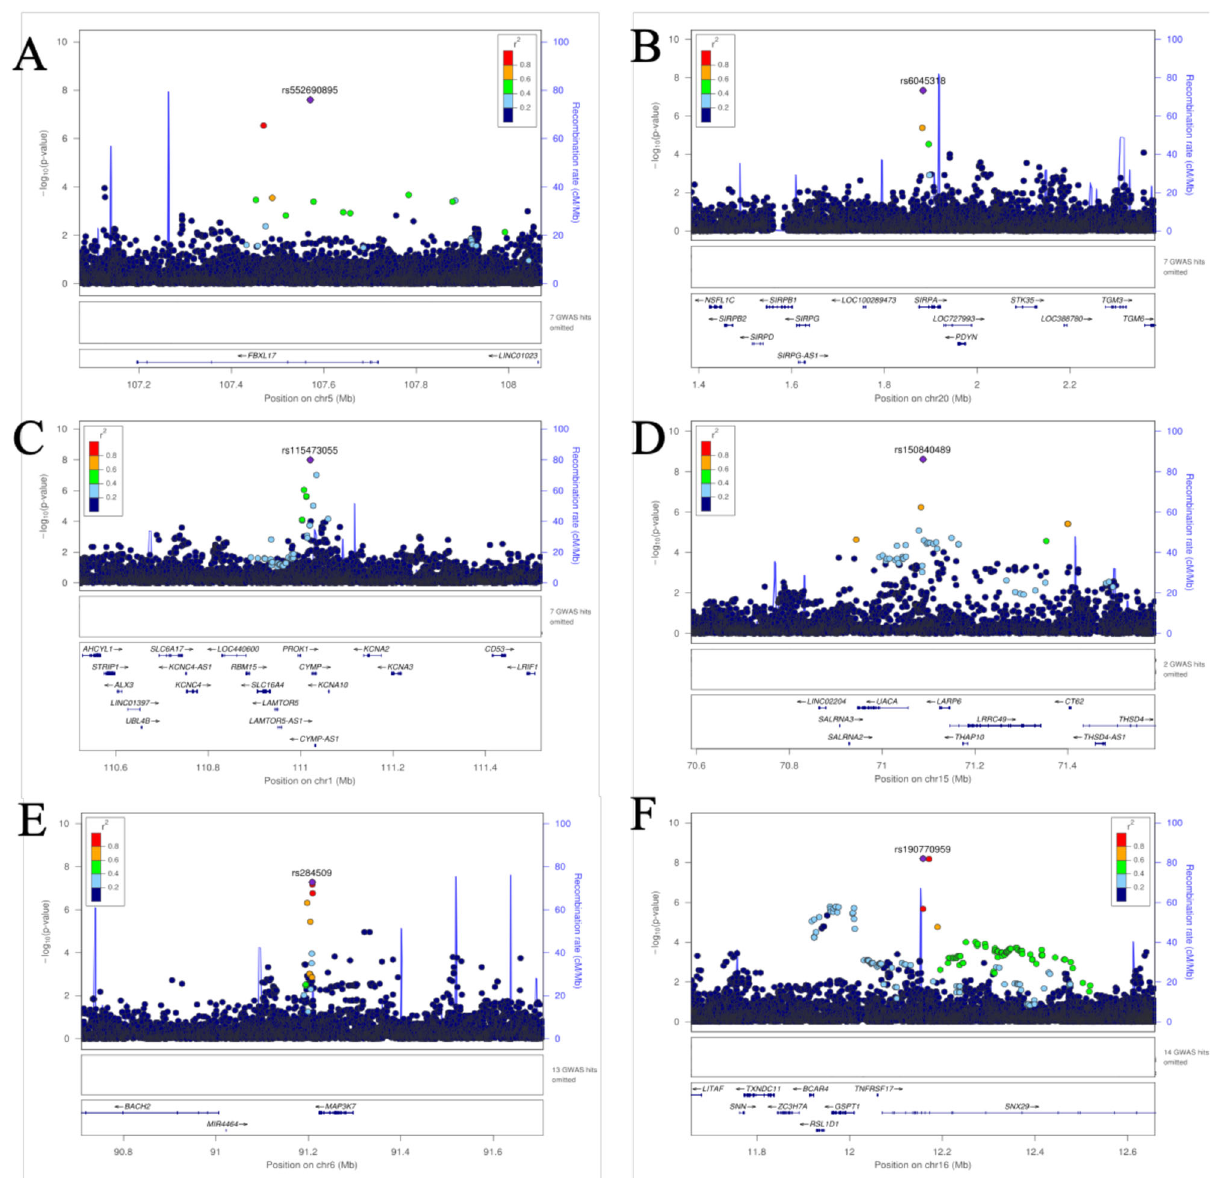
Fig. 2 Regional association plots for selected top SNPs showing genetic associations with mean-max cIMT. A Regional association plot of the FBXL17 region in the combined dataset. B Plot of the SIRPA region in the combined dataset. C Regional association plot of the PROK1 region in the female-speci fi c dataset. D Regional association plot of the LARP6/UACA region female-speci fi c dataset. E Regional association plot of the MAP3K7 region in the male- speci fi c dataset. F Regional association plot of the SNX29 region in the male-speci fi c dataset. For each locus, the plots show the − log10-transformed p- value of each SNP on the y -axis and base-pair positions along the chromosomes on the X- axis. Genes overlapping the locus are displayed below the plot. SNPs are coloured by their LD value r 2 (generated from the study population) with the lead SNP in the region shown as a purple